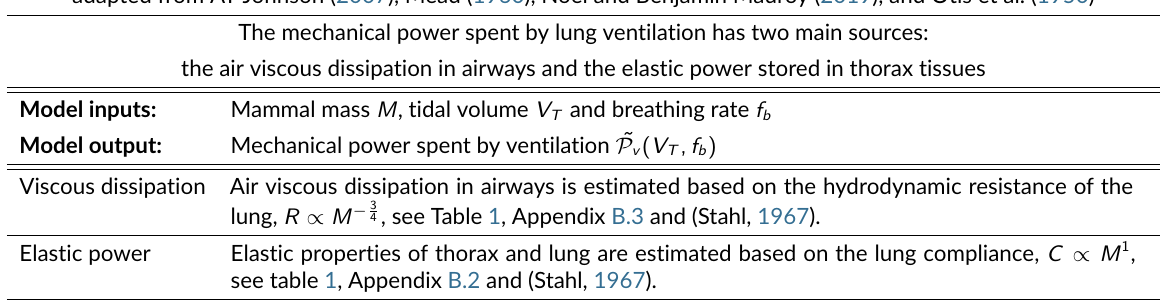
Table 5 – Hypotheses of the model 1 that estimates the power spent for ventilating the lung. Model 1: Power spent for lung ventilation